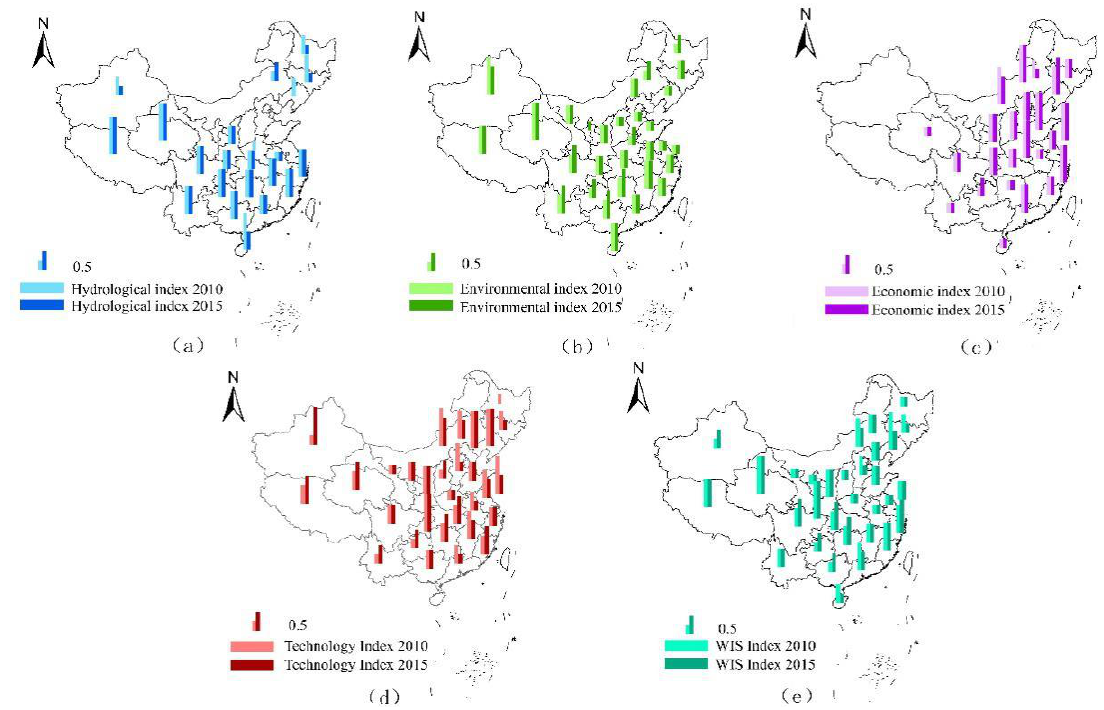
Figure 6. Interannual variation trend of ( a ) Hydrological index, ( b ) Environmental index, ( c ) Economic index, ( d ) Technology index and ( e ) WSI .